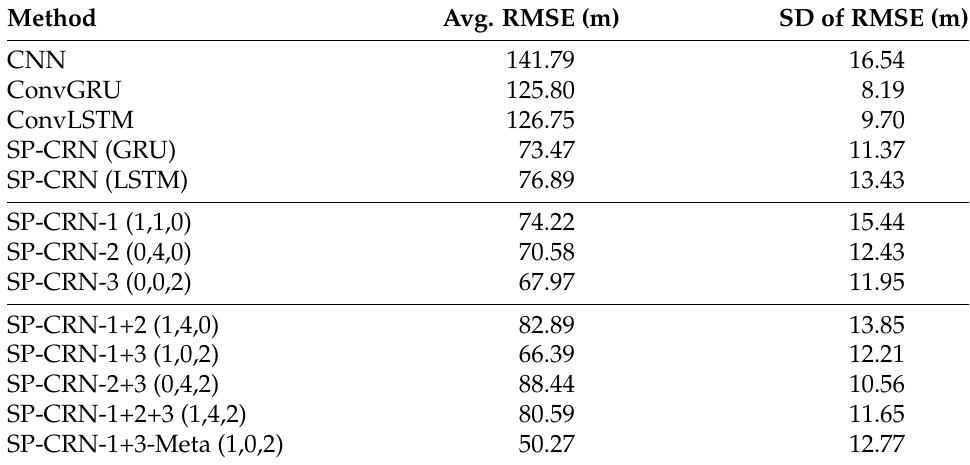
Table 2. Evaluation of different settings on the ZH300 prediction for SP-CRN and comparison